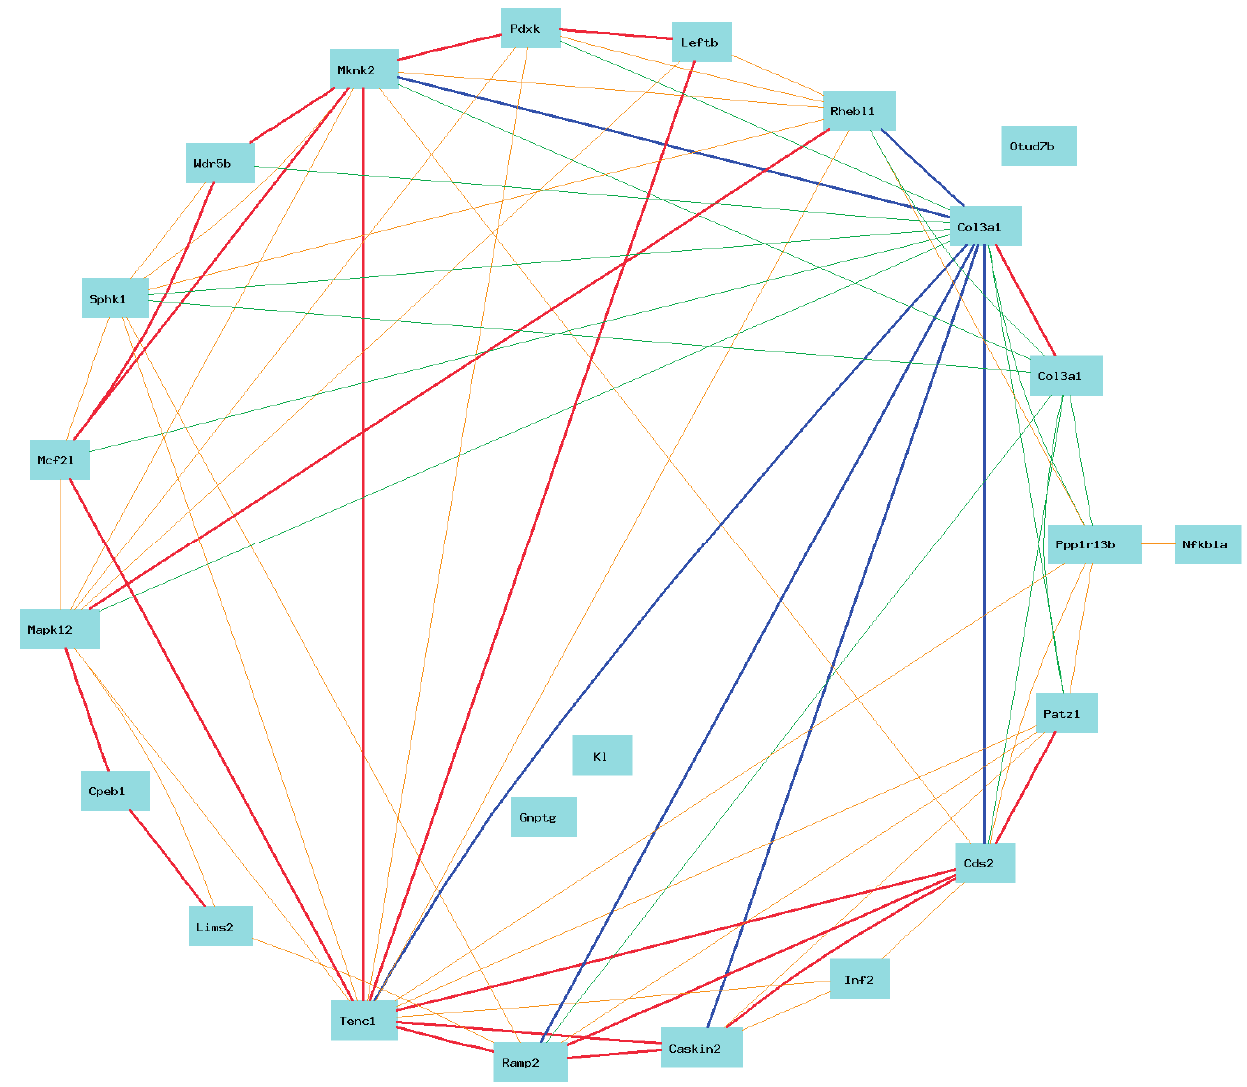
Figure 5. Two probes of Col3a1 show their negative correlation with 21 genes in mice. The 23 nodes in the graph below show the selected traits. All nodes are displayed. The 69 edges between the nodes, filtered from the 253 total edges and drawn as curves, show Pearson correlation coefficients greater than 0.6 or less than − 0.6. The graph’s canvas is 40.0 by 40.0 cm, and the node labels are drawn with a 16.0 point font, and the edge labels are drawn with a 16.0 point